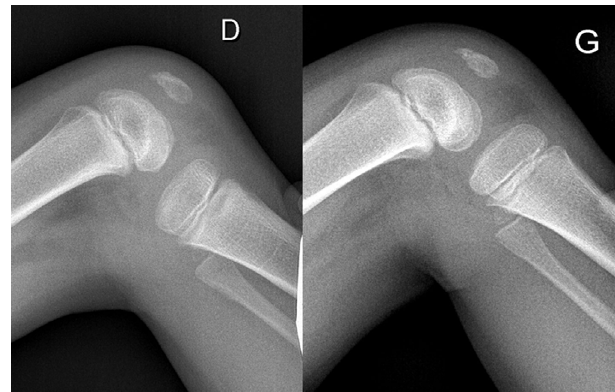
Figure 1. Case 1. Posterior drawer sign with more 10 mm on stress radiographs of the right knee. No bony avulsion was noticed.